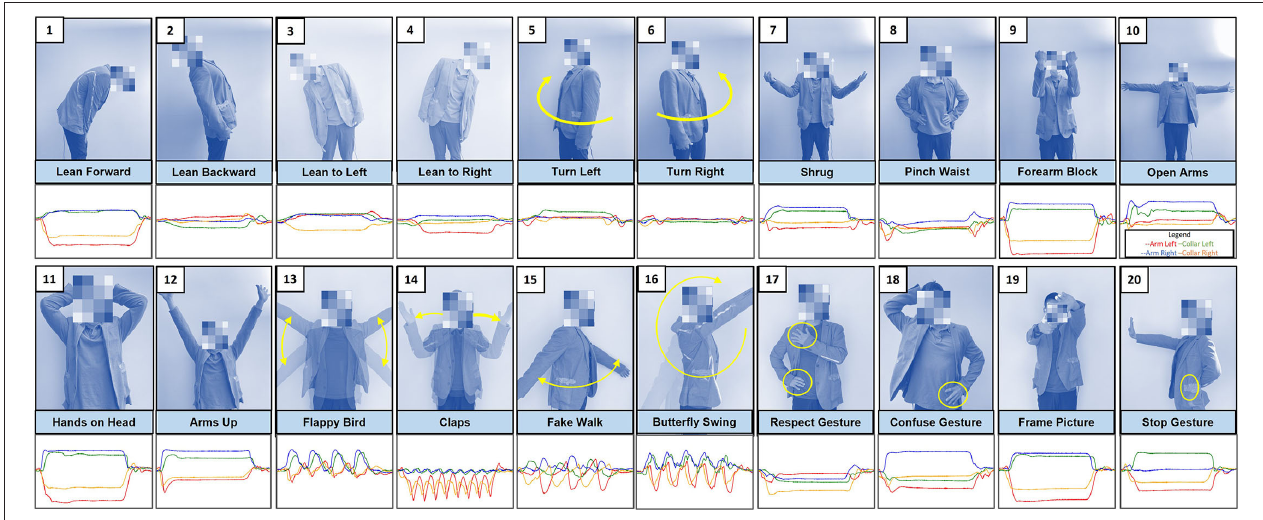
FIGURE 2 | Twenty general upper-body gestures/postures dictionary with example signals. x = (0,400) time steps, y :norm.